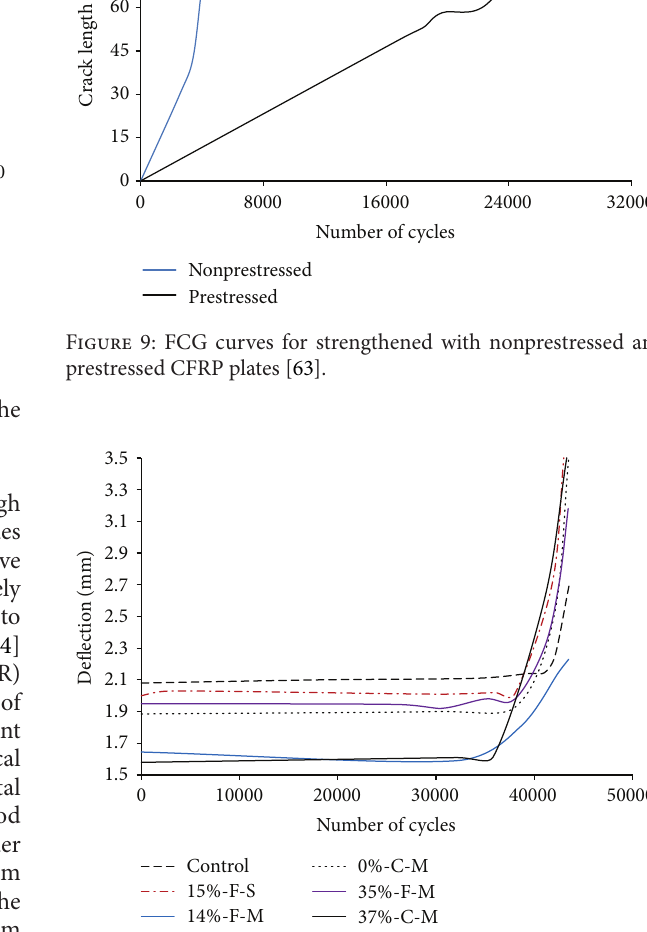
Figure 10: Deflection versus number of cycle curves for strength- enedsteelbeamusing14%,15%,35%,0%,and37%prestressedCFRP plates